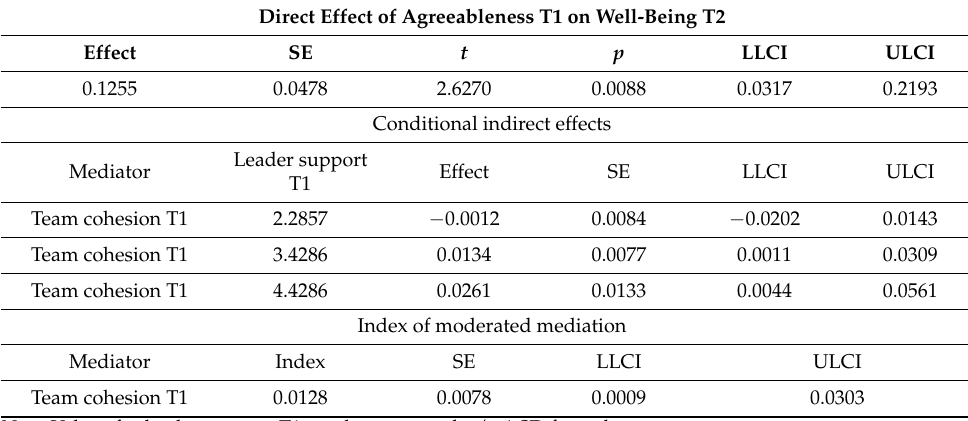
Table 3. Direct and conditional indirect